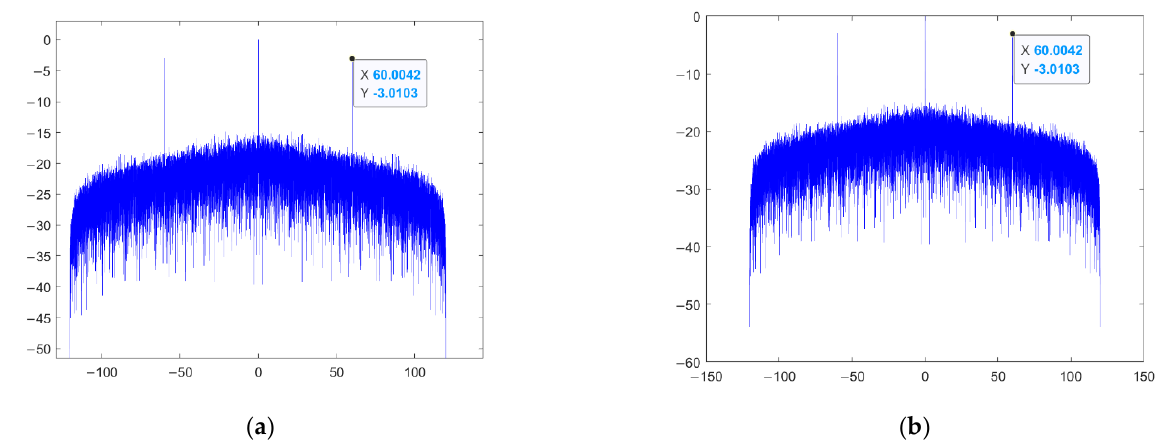
Figure 13. Period estimation results are based on autocorrelation: ( a ) The result of autocorrelation- based period estimation at an SNR of 5 dB. ( b ) The result of autocorrelation-based period estimation at an SNR of 0 dB.